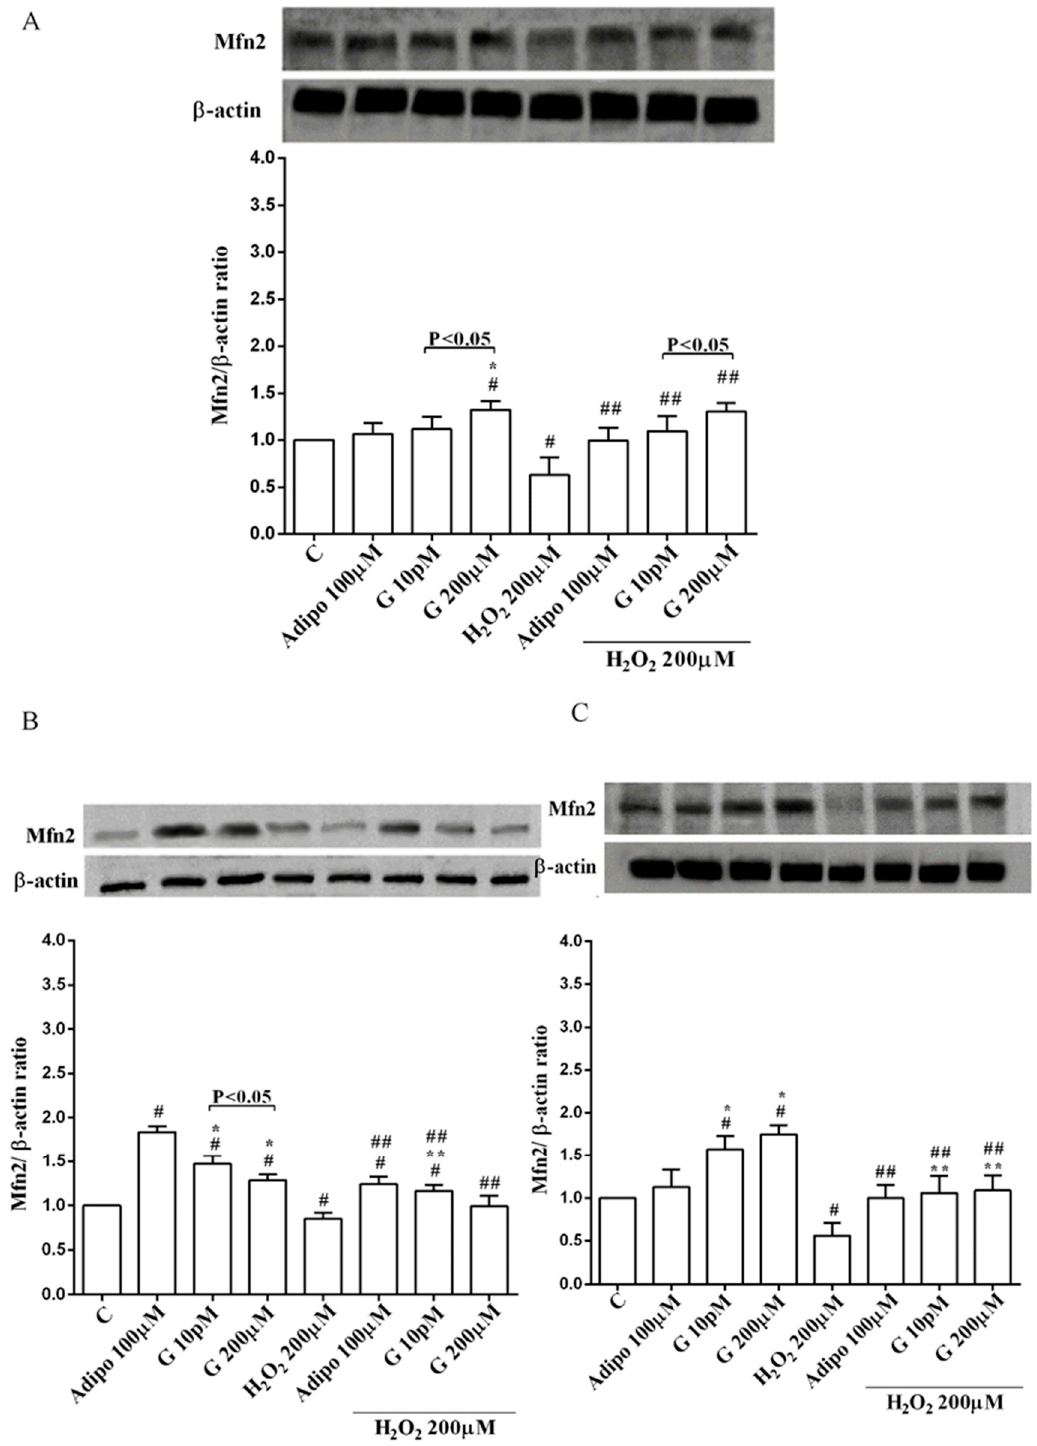
Figure 9. Effects of genistein on Mfn2 expression in pre-adipocytes ( A ), white adipocytes ( B ) and brown adipocytes ( C ), cultured in physiological and peroxidative conditions: Abbreviations are as in previous figures. Reported data are means ± SD of five independent experiments for each experimental protocol executed in adipocytes taken from each patient. Significance between groups: # p < 0.05 vs. control; * p < 0.05 vs. Adipo 100 µM; ## p < 0.05 vs. H2O2 200 µM; ** p < 0.05 vs. Adipo 100 µM + H2O2 200 µM. Short square brackets indicate significance between groups ( p < 0.05).